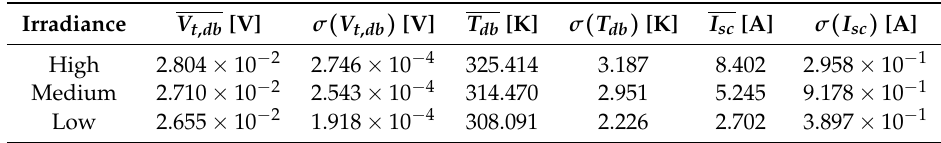
Figure 15. Left : Experimental (dots) and reproduced (line) I-V curve of the bypass diode in submodule 1 for low irradiance level. Right : percentage errors of the bypass diode voltage. Table 7. Thermal voltage and temperature for bypass diode in submodule 1 and short-circuit current for high, medium and low irradiances from experimental data.